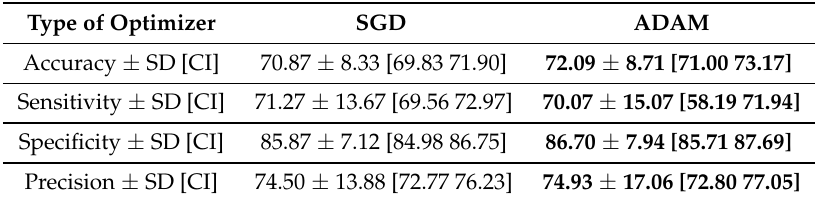
Table 6. Accuracy, Sensitivity, Specificity and Precision for Different Optimizer Using LSTM. (The Numbers in Bold Indicate the Best Value Obtained for Each Quality